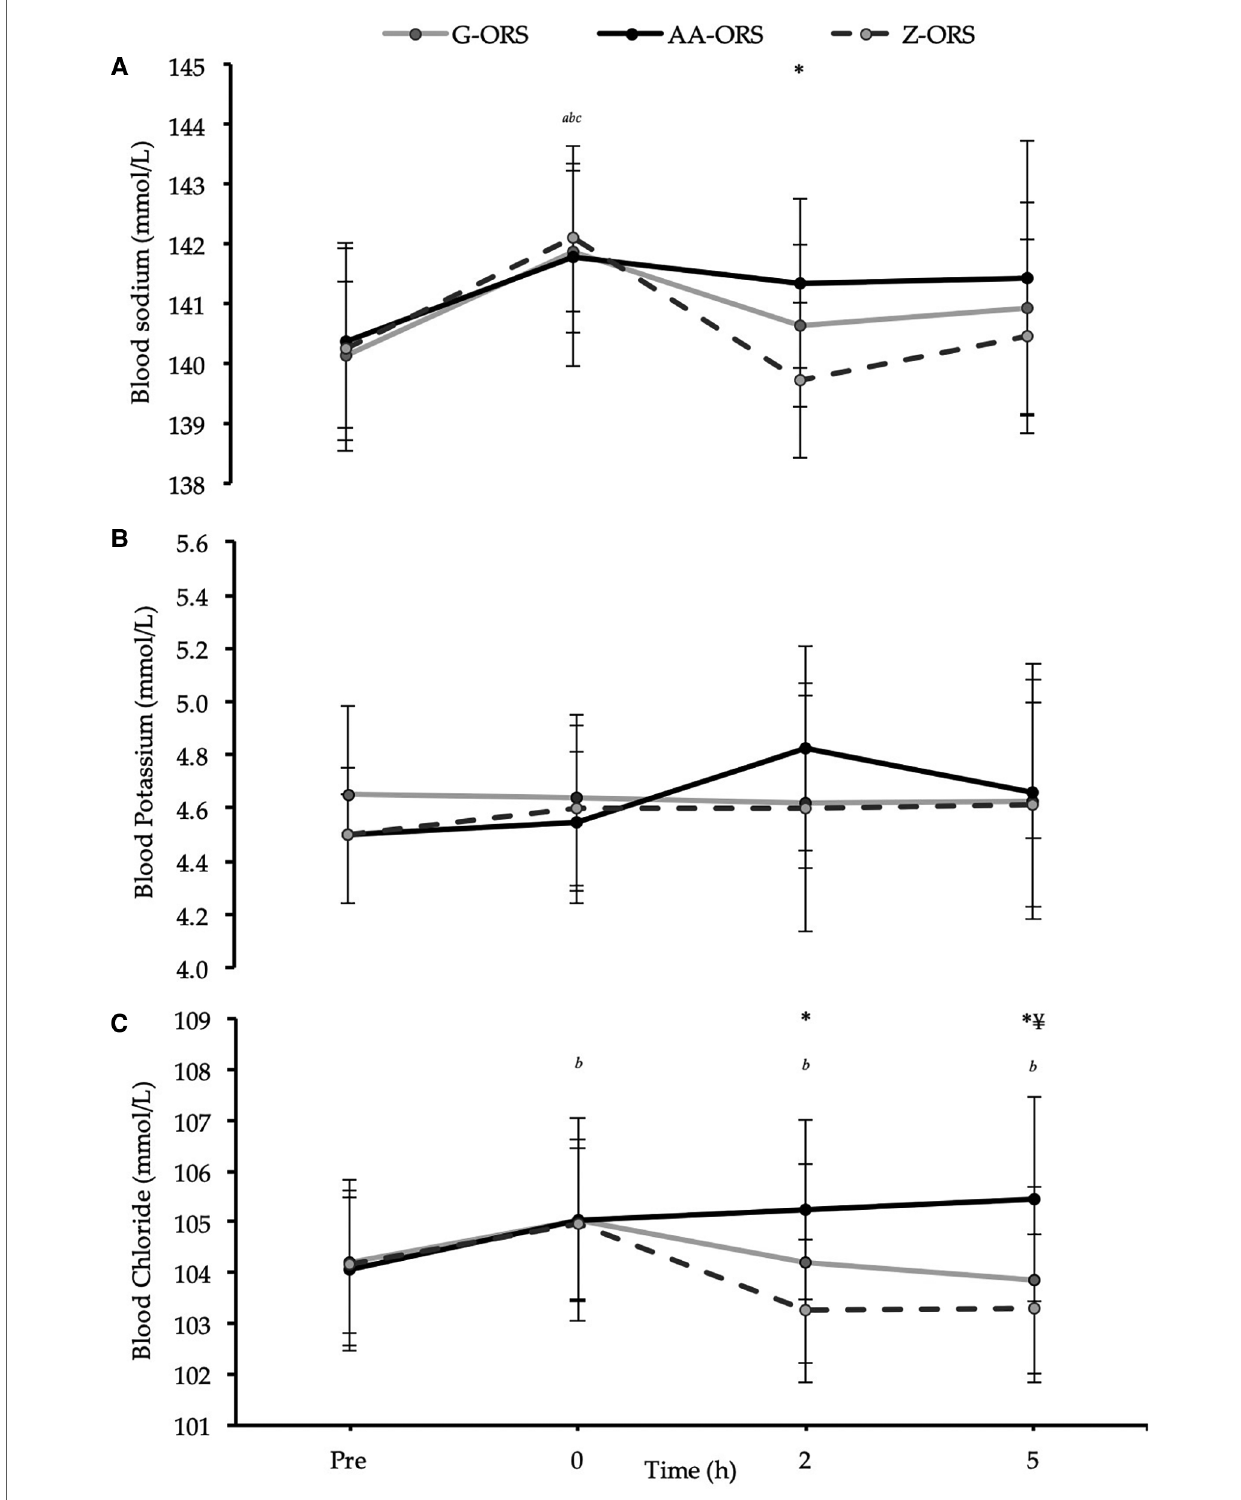
FIGURE 7 Blood electrolyte concentrations from baseline (Pre) and during the rehydration phase. ( A ) Sodium; ( B ) Potassium; ( C ) Chloride. P <0.05: *, AA-ORS greater vs. Z-ORS; ¥, AA-ORS greater vs. G-ORS; a , G-ORS vs. baseline, b , AA-ORS different vs. baseline; c , Z-ORS different vs.